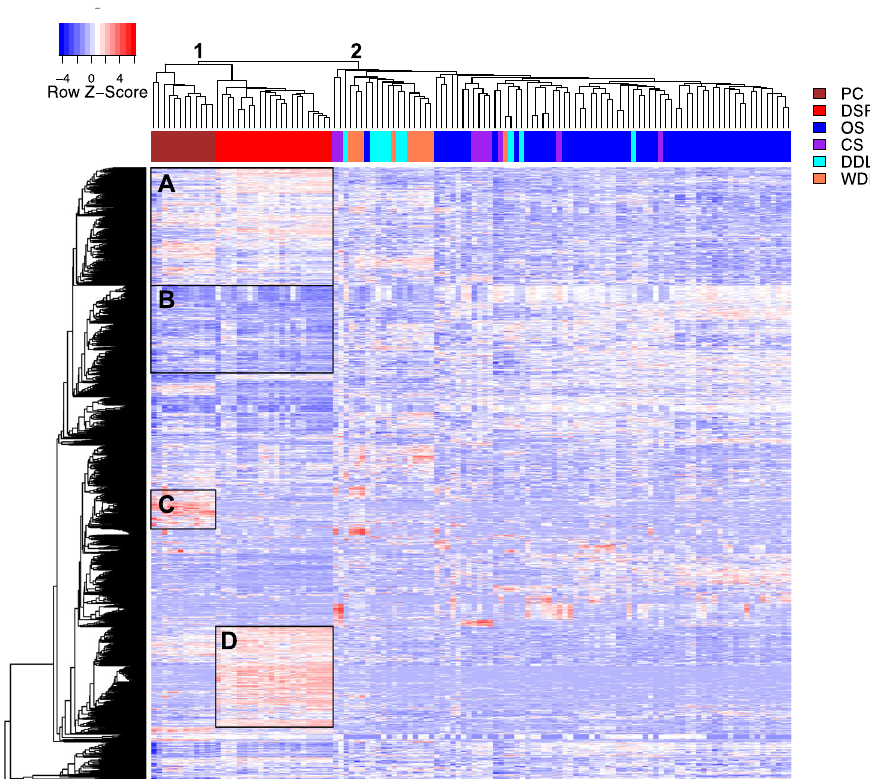
Fig. 3 Double-hierarchical clustering of PC ( n = 12), DSRCT ( n = 22), and other sarcoma subtypes ( n = 71). The top 1500 most variable genes across all samples were used to compare DSRCT to PC and other sarcoma subtypes. Unsupervised double-hierarchical clustering placed DSRCT next to PC on branch 1. Other sarcoma subtypes clustered on branch 2. Distinct blocks within the heatmap indicate genes overexpressed (A) or underexpressed (B) in PC and DSRCT compared to other sarcoma subtypes. Within the branch 1, some genes were upregulated strictly in PC (C) compared to DSRCT (D). PC = prostate cancer ( n = 12); OS = osteosarcoma ( n = 47); CS = chondrosarcoma ( n = 7); WDLPS = well-differentiated liposarcoma ( n = 7), and DDLPS = dedifferentiated liposarcoma ( n =